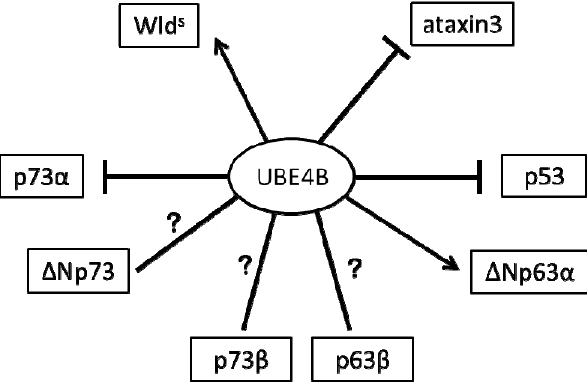
Figure 1. Schematic model for UBE4B showing the inhibition ( ), stabilization ( ), or possible relation (?) with p53 family proteins, Wallerian pathway, and polyglutamination in neurodegenerative